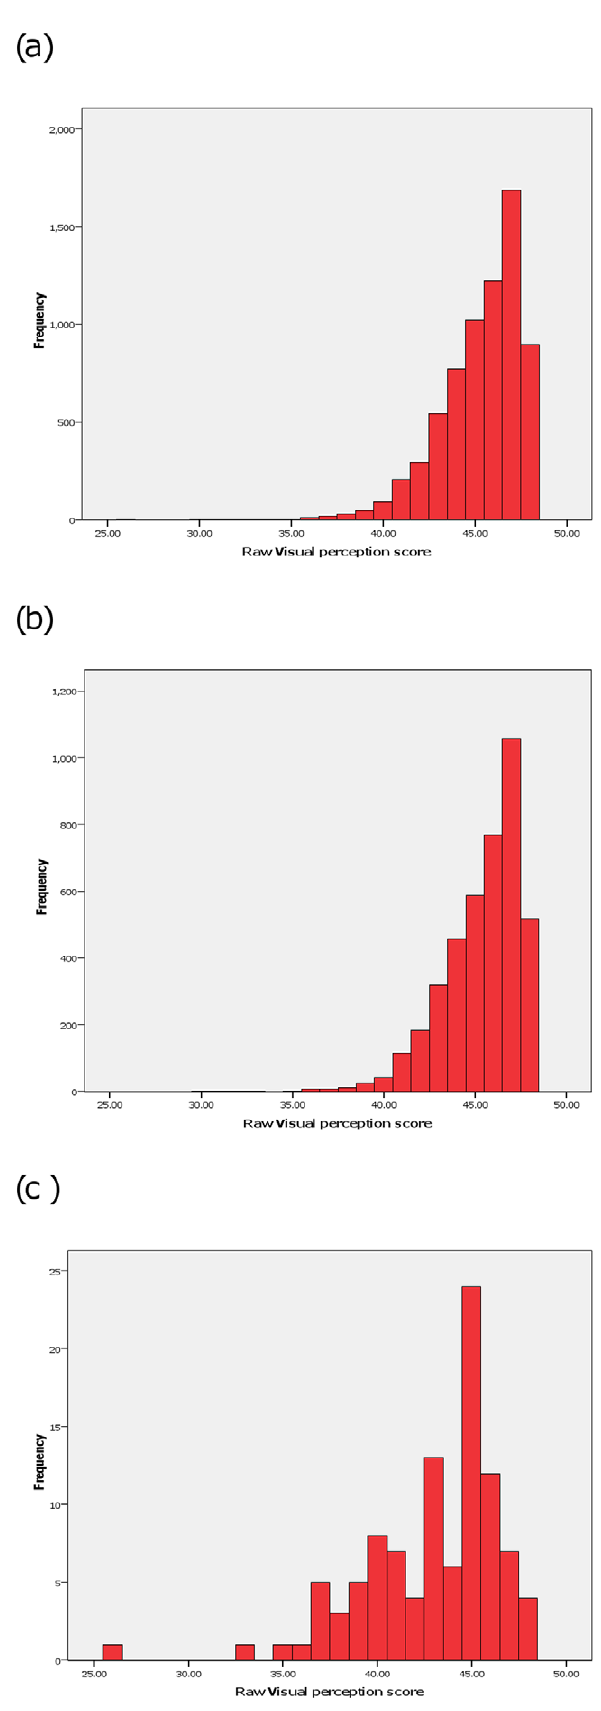
Figure 1. Distributions of raw scores obtained by summing maternal responses to 12 questions on visuoperceptual abilities in their 13-year old children. Legend: (a) all who responded (n=6870), (b) included in analysis (4414) and (c) with an ICD-10 diagnosis affecting development (n=102).